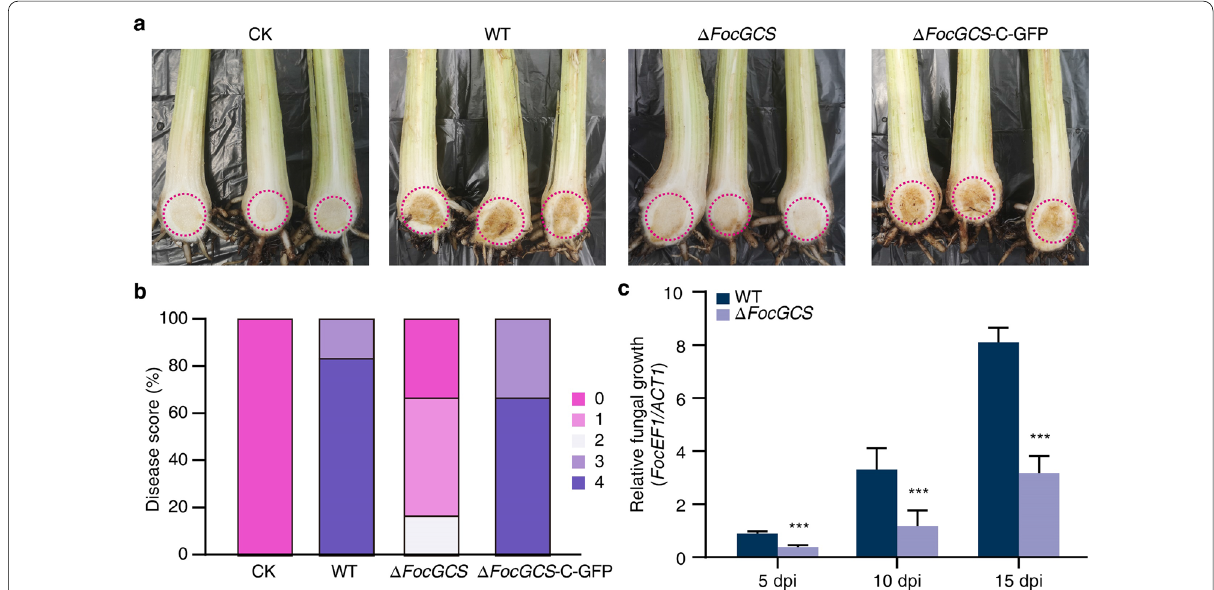
Fig. 5 Foc GCS is required for full virulence of Fusarium oxysporum f. sp. cubense tropical race 4. a Symptoms on banana roots at 30 days post‑inoculation (dpi). The Cavendish banana variety Brazilian ( Musa spp. AAA group) was inoculated with the WT, ∆ FocGCS , and complemented strains. Images are representative of three independent experiments. b Disease score of the inoculated banana plants at 30 dpi. Disease severity was assessed on a scale of 0–4. The disease score (%) (the number of inoculated banana plants with different disease severity) / (the number = of total inoculated banana plants) 100. c Fungal biomass in roots of the inoculated plants. Relative fungal growth in planta was evaluated by × qRCR analysis of FocEF1α and banana ACT1 and shown as a ratio of FocEF1α / ACT1 . The mean values SD were calculated from three independent ± experiments, and asterisks indicate significant differences from the WT group (Student’s t ‑test, *** P <